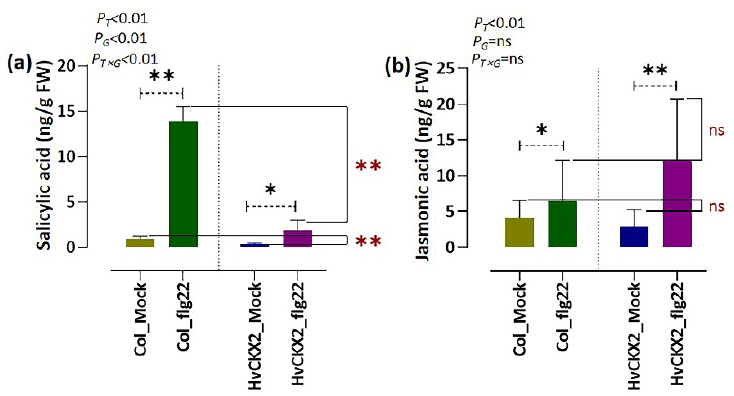
Figure 4. Concentration of ( a ) salicylic acid (SA) and ( b ) jasmonic acid (JA) in the leaves of Arabidopsis Col-0 and HvCKX2 genotypes 24 h after treatment with 1 µ M flg22 or ddH 2 O (mock). Bars represent the mean of seven biological replicates. Black asterisks indicate significant differences between flg22-treated Arabidopsis plants and their corresponding control plants within the same genotype. Red asterisks indicate significant differences between HvCKX2 Arabidopsis plants and wild-type plants within the same treatment (* significant at p < 0.05; ** significant at p < 0.001; ns, not significant; two-sided Student’s t -test). Probability value ( p ) indicates results of two-factor ANOVA (letter ‘T’ represents treatment (Flg22 and Mock); letter ‘G’ represents genotype ( HvCKX2 and Col_0); ’T × G’ represents interaction between genotype and treatment).